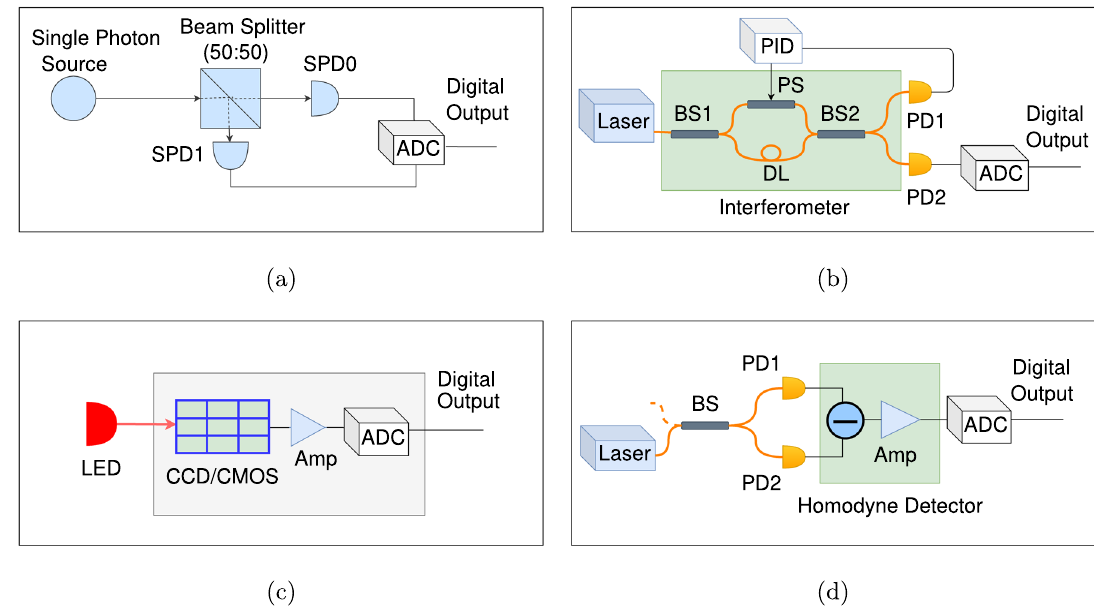
Fig. 1 Schematic diagram of QRNG devices based on various quantum principles. BS: beam splitter 50/50, PD: photodetecotr, SPD: single- photon detector, ADC: analogue to digital converter, PID: proportional-integral-derivative control, PS: phase-shifter, DL: delay line, Amp: ampli fi er. a Single-photon-detection QRNG. b Phase- fl uctuation QRNG. c Photon-counting-detection QRNG. d Vacuum- fl uctuation